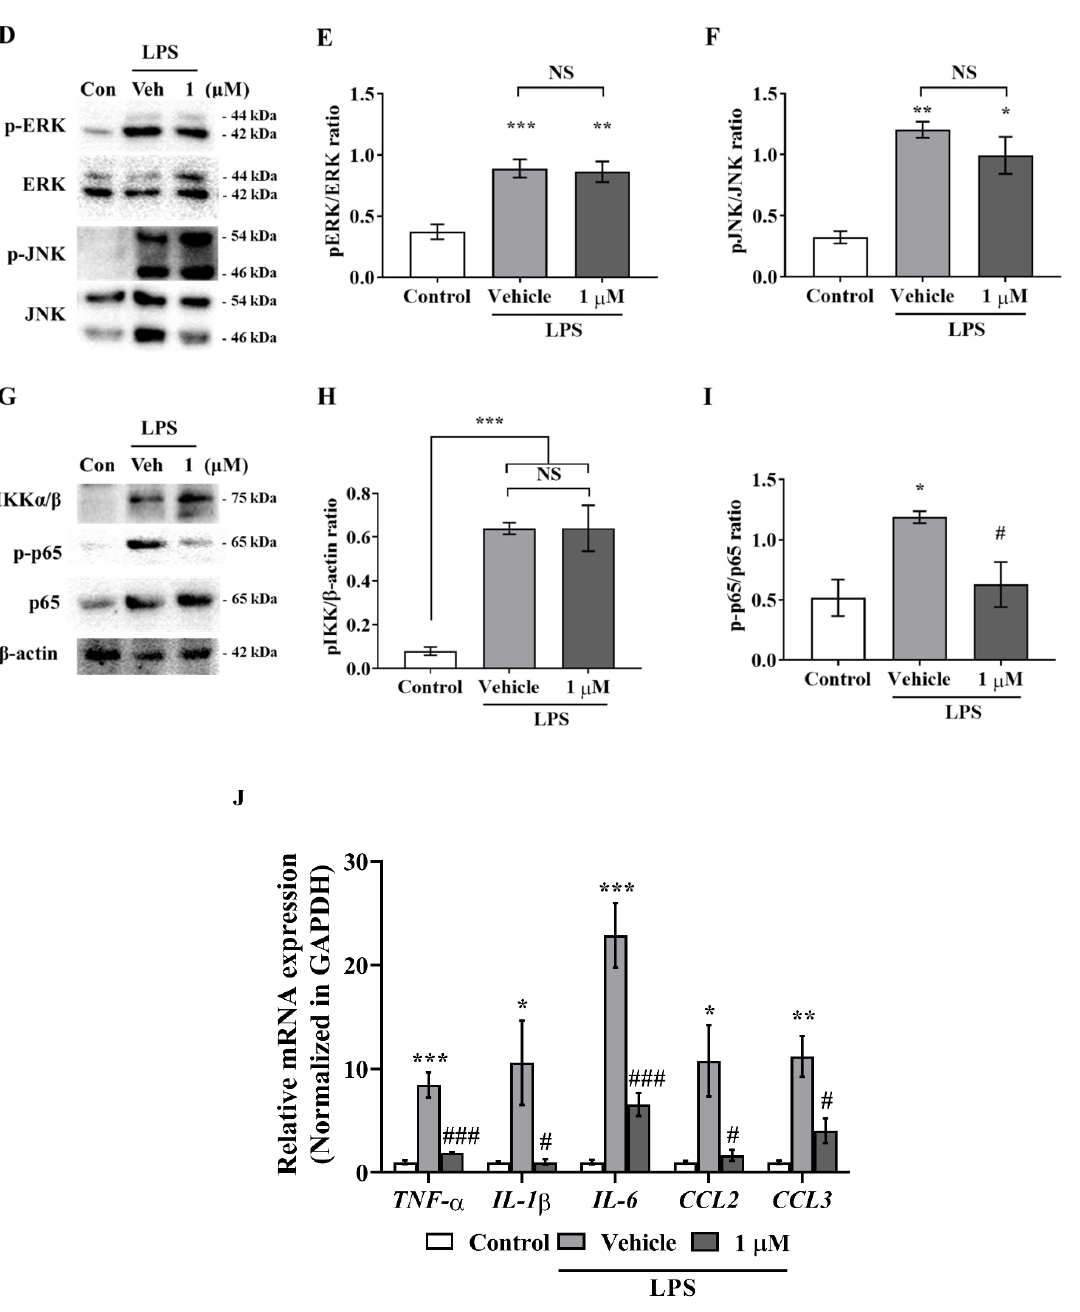
Figure 2. Anti-inflammatory effect of IAGIP on BV-2 cells. ( A ) Representative images showing that IAGIP inhibited the migration activity of BV-2 cells (a microglial cell line). Scale bar = 100 µm. ( B ) Scratch areas were measured. Values are means ± SEs ( n = 4–5). *** p < 0.001 vs. vehicle-treated controls and ### p < 0.001 vs. LPS-treated controls. ( C ) The number of migrated cells was counted. Values are means ± SEs ( n = 5–6). *** p < 0.001 vs. vehicle-treated controls and ### p < 0.001 vs. LPS-treated controls. ( D , G ) Western blotting confirmed that IAGIP reduced inflammatory response in BV-2 cells without influencing MAPK phosphorylation. ( E , F , H , I ) Densitometric analysis of Western blots. More than three independent experiments were performed ( n = 3–5). *** p < 0.001, ** p < 0.01, and * p < 0.05 vs. vehicle-treated controls, and # p < 0.05 vs. LPS-treated controls. ( J ) RT-PCR showed that IAGIP dramatically reduced LPS-induced inflammatory cytokine and chemokine levels. Values are means ± SEs ( n = 3–4). *** p < 0.001, ** p < 0.01, and * p < 0.05 vs. vehicle-treated controls, and ### p < 0.001 and # p < 0.05 vs. LPS-treated